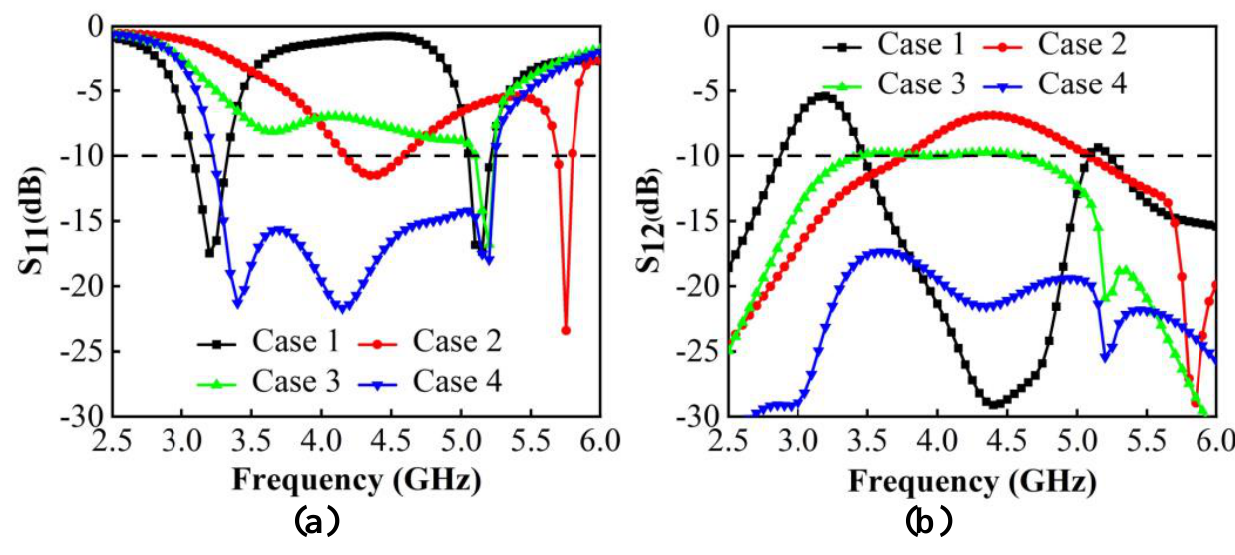
Figure 3. Evolution of S-parameters. ( a ) Reflection coefficients. ( b ) Transmission coefficients.